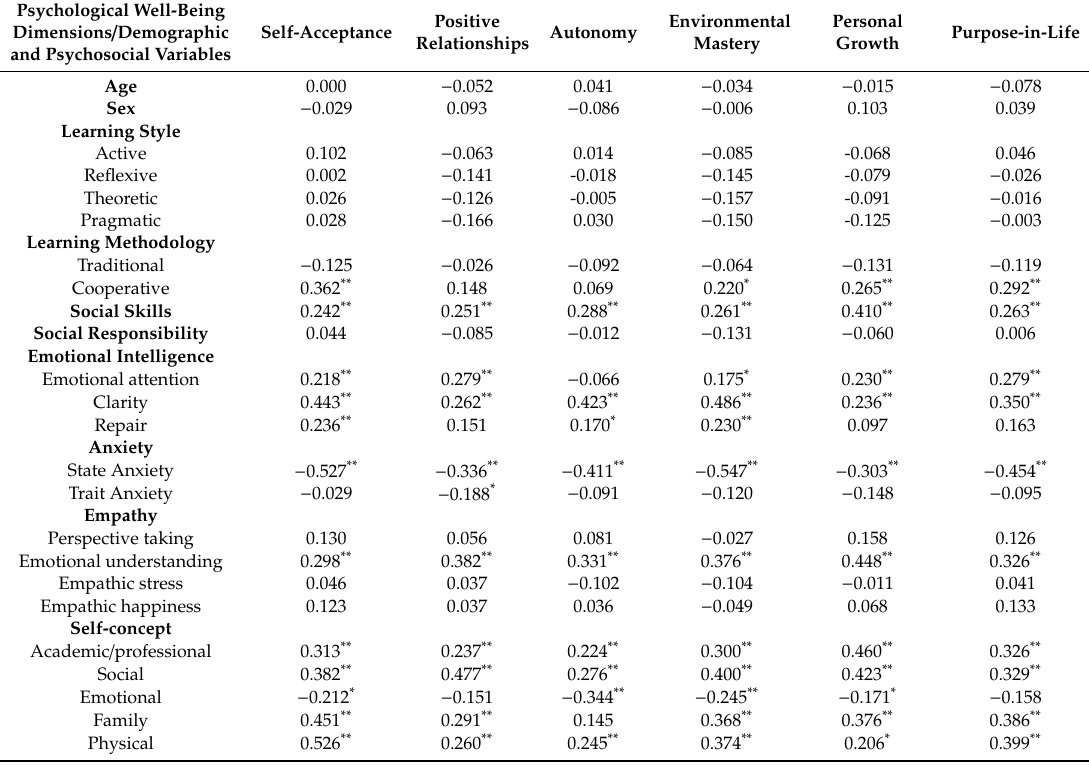
Table 2. Correlations between psychological well-being and age, sex, learning style and methodology, level of social responsibility, empathy, anxiety, social skills, level of self-concept and emotional intelligence in university